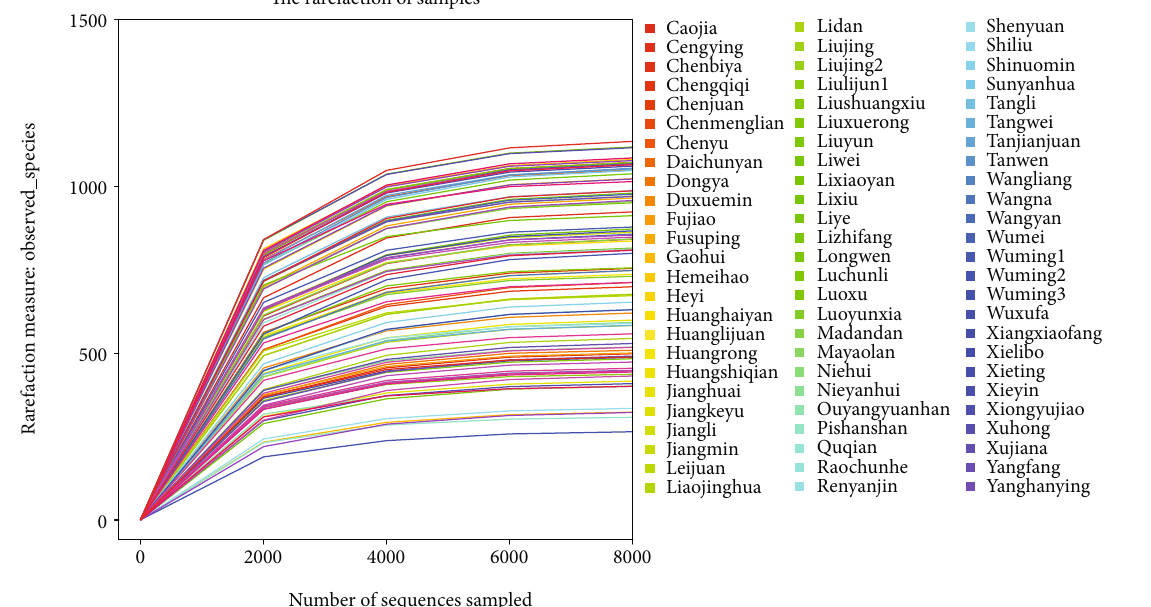
Figure 2: Dilution curve of each sample. The abscissa represents the number of sequences, and the ordinate represents the number of OTUs observed. According to the endpoint of the extension of the sample curve, the number of sequencing samples was found to correspond to the abscissa.